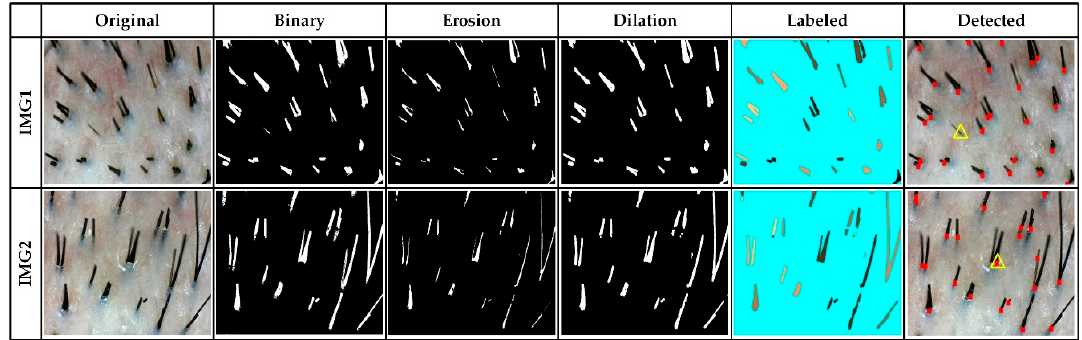
Figure 16. Hair root detection results for two close-up hair images.